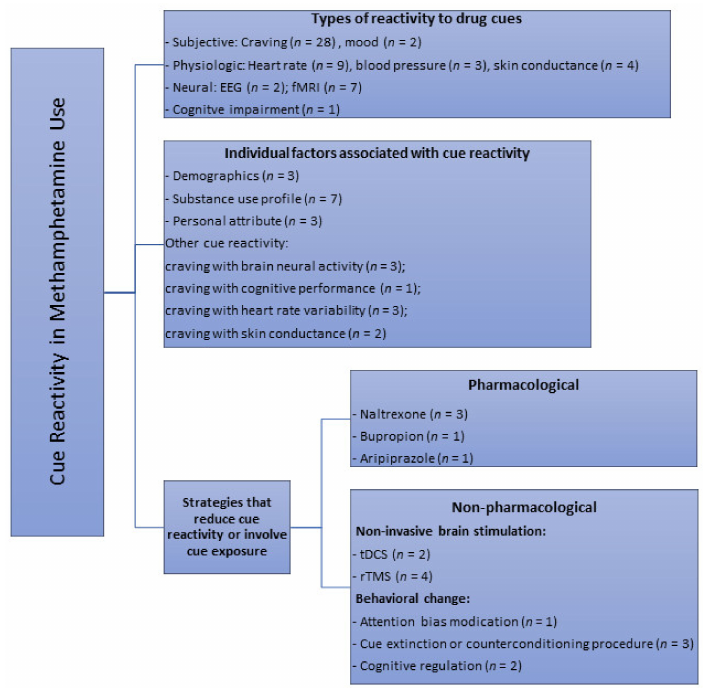
Figure 2. Key themes of cue reactivity or areas of cue paradigm applications identified from primary studies in methamphetamine research through the scoping review. n = number of available